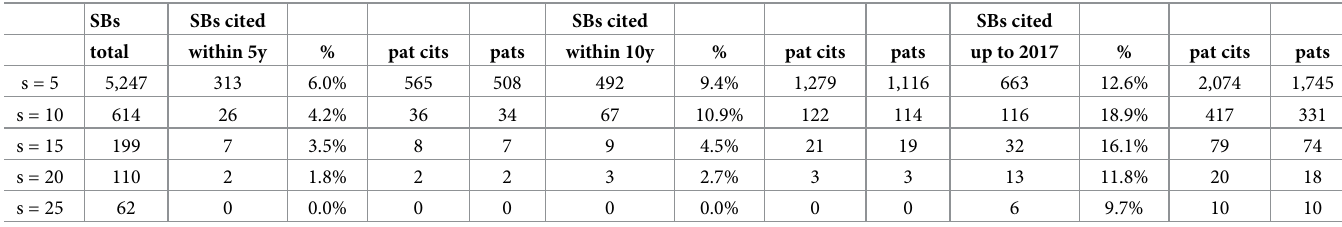
Table 4. Number of SBs cited by